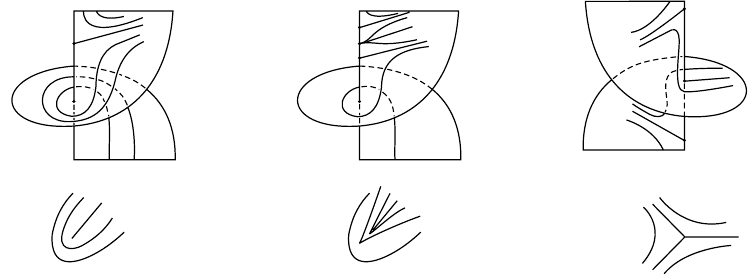
Fig. 3 – Behavior of X in a neighborhood of the projective line and projection of the integral curves.